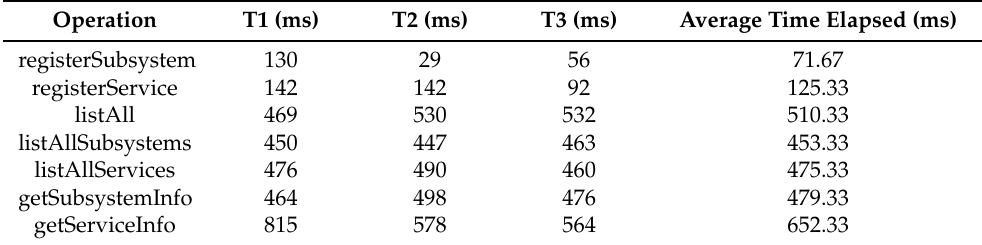
Table 3. Response time when the first request is done to the semantic repository.